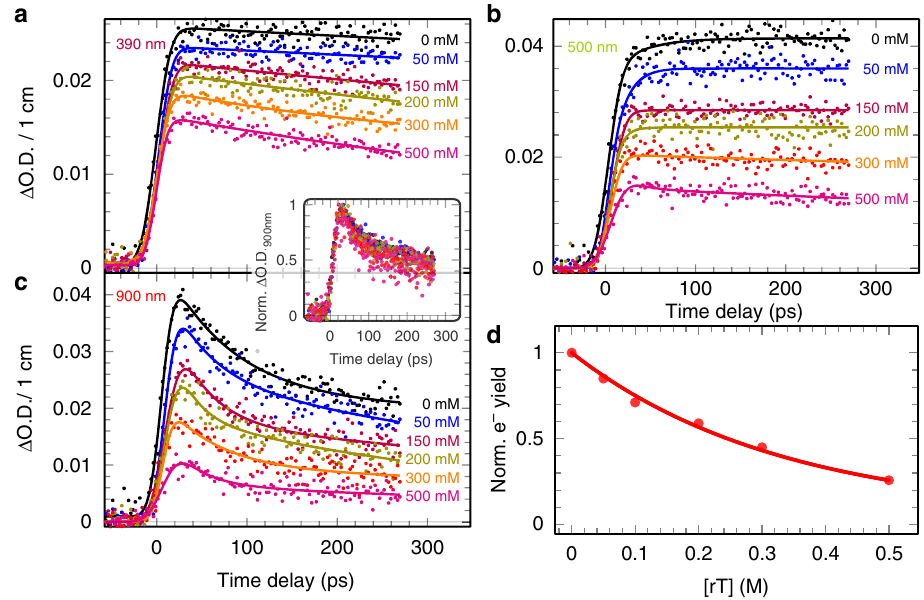
Fig. 3 Transient absorption kinetics at various ribothymidine concentrations. Kinetics at wavelengths: a 390 nm, b 500 nm, and c 900 nm. The inset shows the normalized kinetics at 900 nm at different concentration of ribothymidine (rT). Electron solvation is shown to be complete within about 300 ps and the geminate recombination between the electron and hole can be neglected at this timescale. d Relative electron yield in the presence of